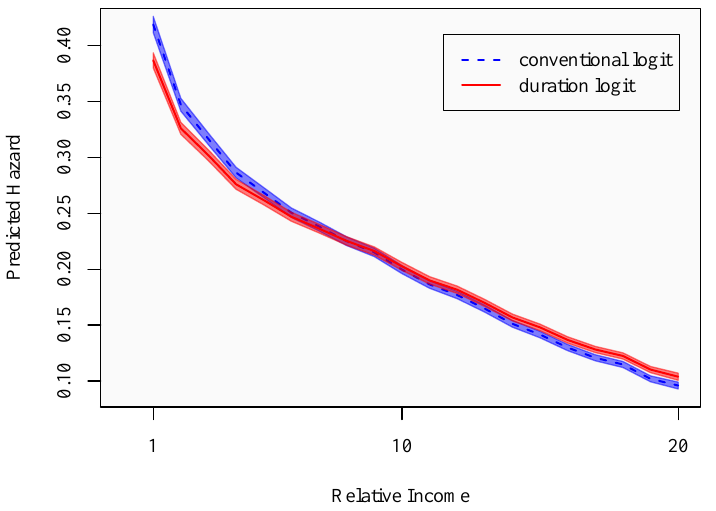
Figure 4. The effect of relative income on the sickness absence